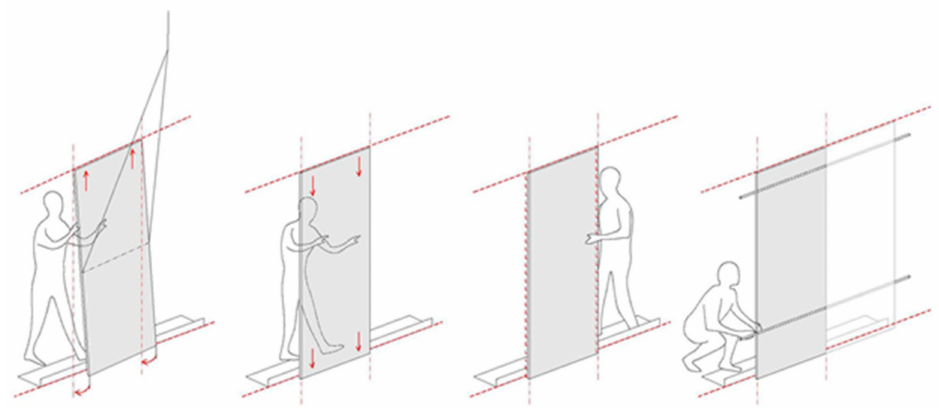
Figure 7. Sequence of placement of the collector and non-collector ceramic panels on the designed structure. Reproduced with permission from reference